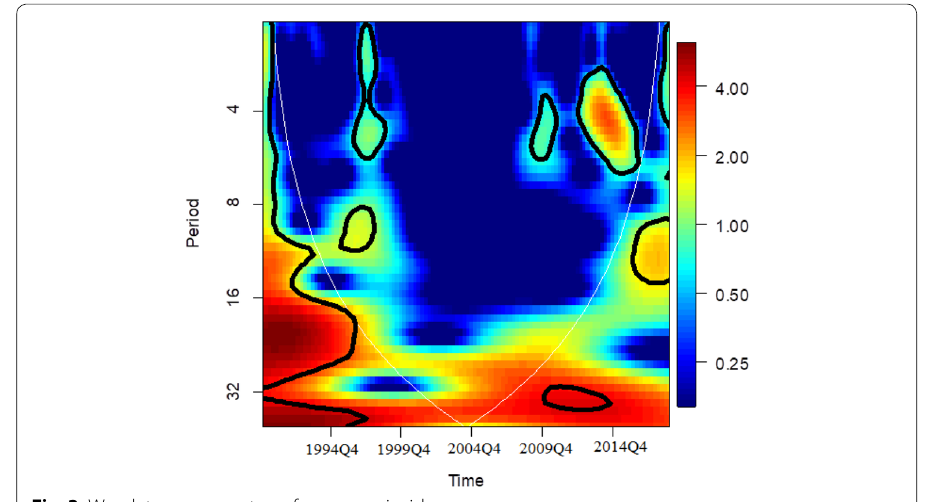
Fig. 3 Wavelet power spectrum for economic risk